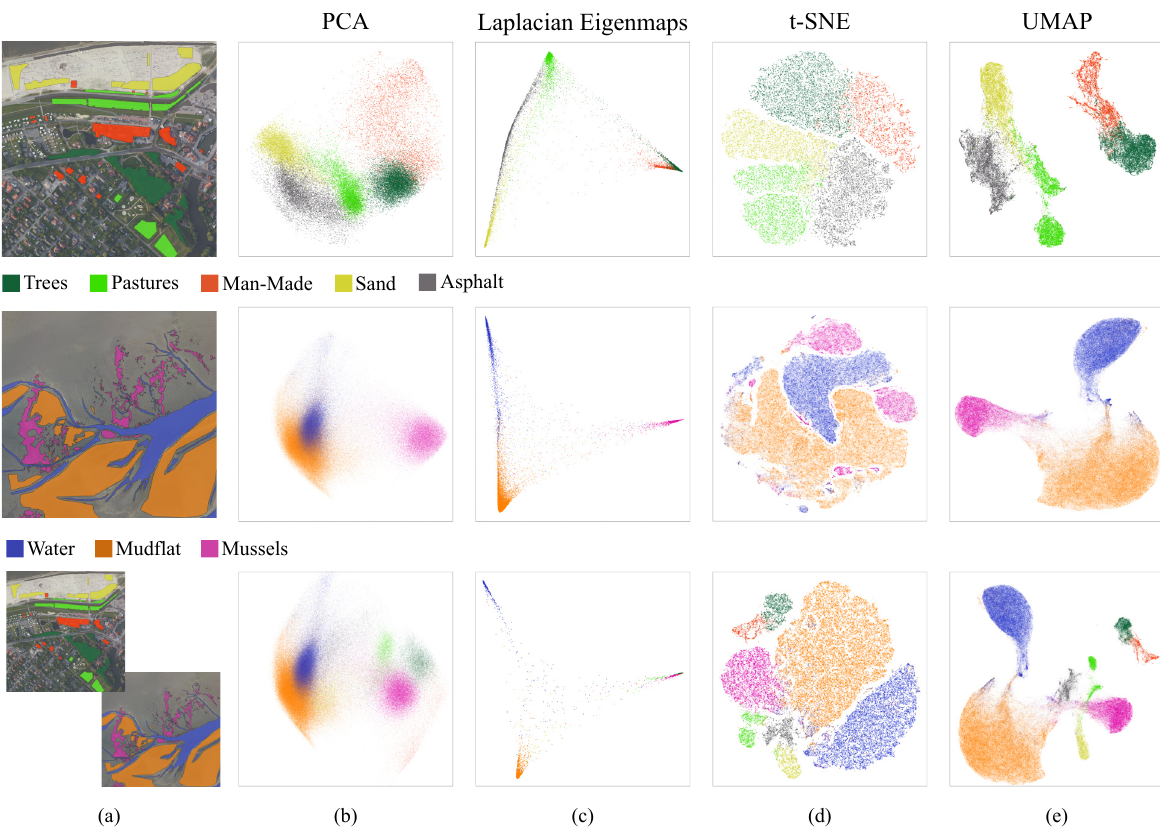
Figure 1. Comparison of 2D feature representations, derived by different dimension reduction methods. In (a) orthophotos of the selected scenes are given, overlaid with labeled reference classes. In (b) to (e) 2D embeddings derived from PCA, LE, t-SNE and UMAP are shown. Embeddings illustrated in the first and second row contain points from only one scene, while embeddings illustrated in the third row are joined embeddings calculated based on points of both scenes. Embedded data points are colored by their corresponding class